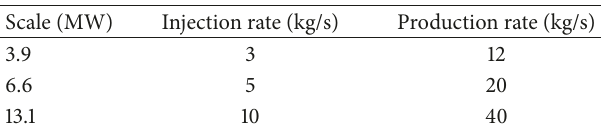
Table 2: The injection and production rates in the three energy storage scale